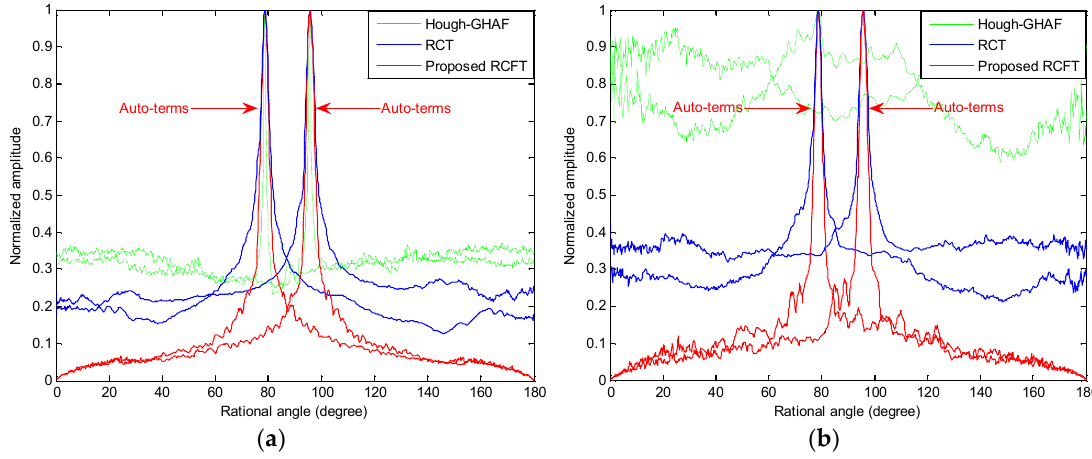
Figure 4. Comparison results of the three methods. ( a ) The slice obtained by the Hough-GHAF, RCT, and the proposed RCFT methods at SNR = 5 dB; ( b ) the slice obtained by the Hough-GHAF, RCT, and the proposed RCFT methods at SNR = –5 dB.